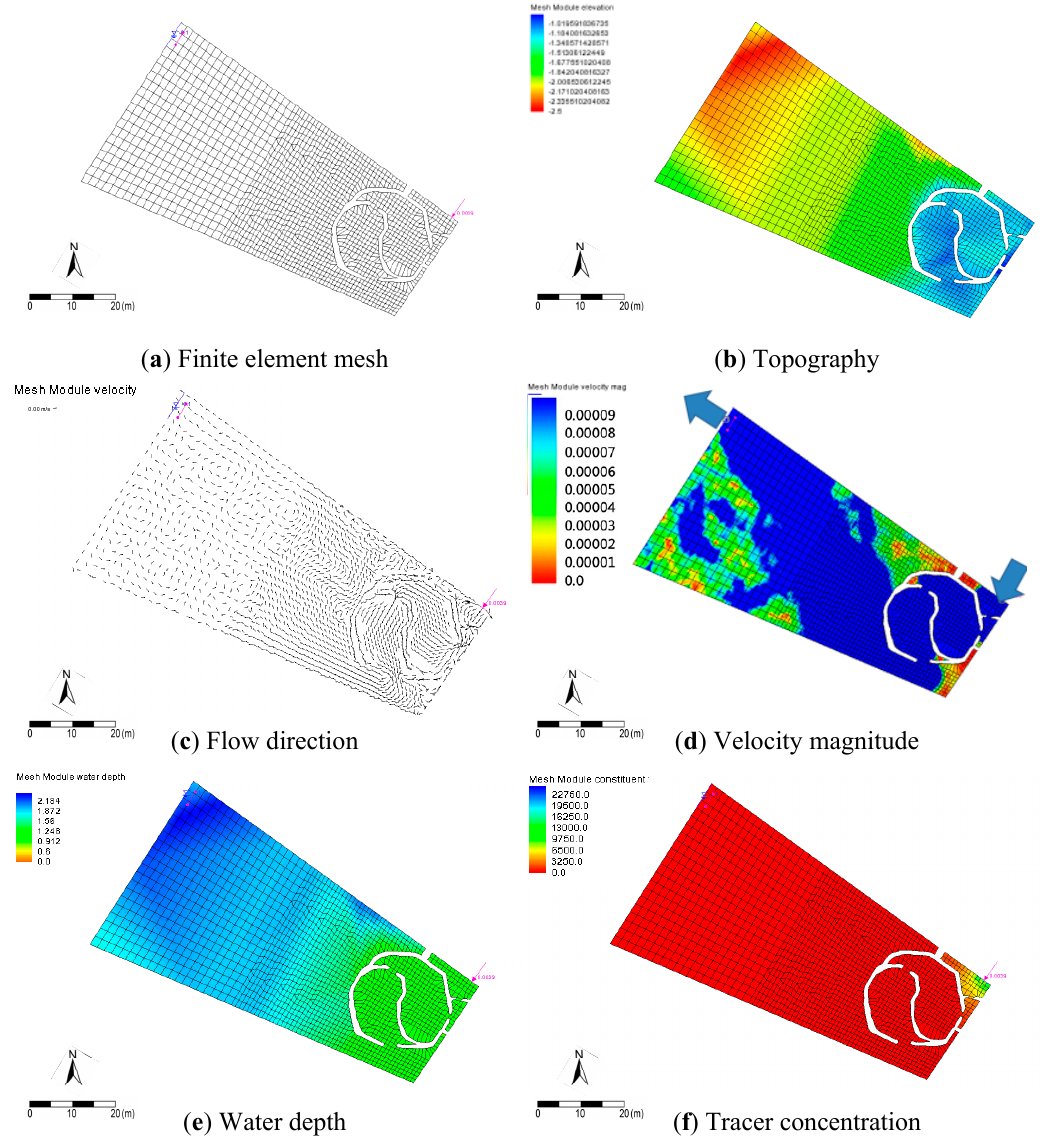
Figure 3. ( a ) Finite element mesh; ( b ) bathymetry; ( c ) flow direction; ( d ) flow velocity; ( e ) water depth; and ( f ) tracer concentration distribution in the pond.